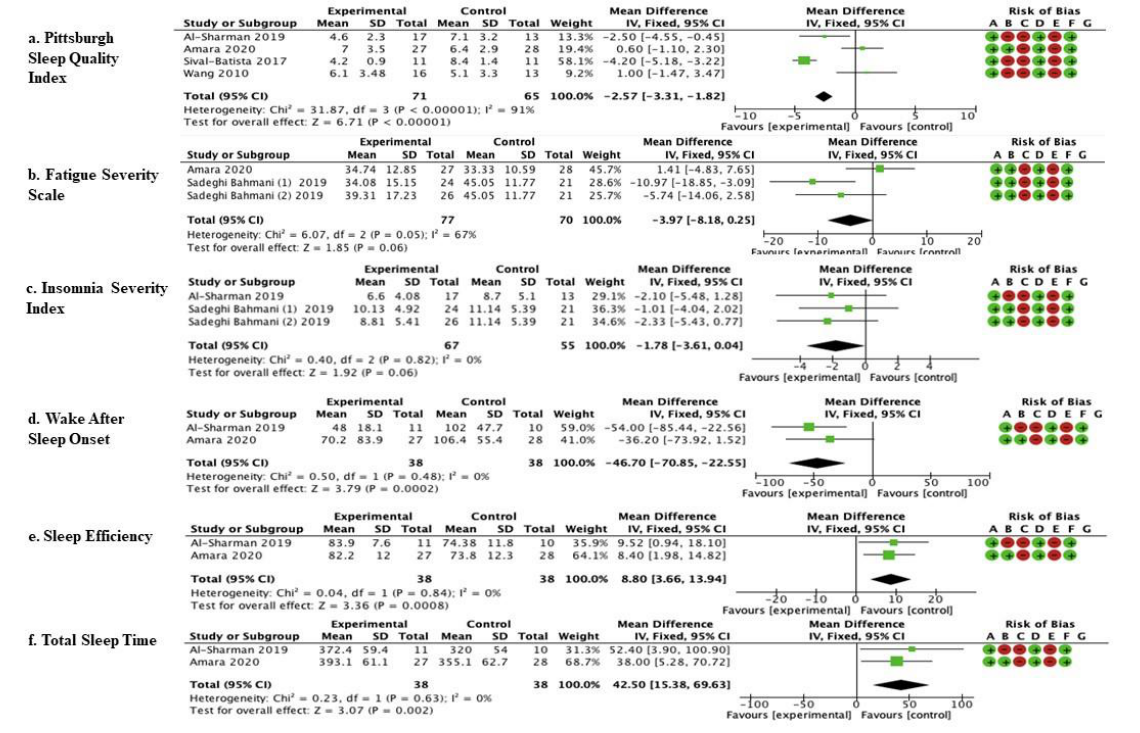
Figure 3. Comparison of physical therapy vs. comparison therapy assessed with clinical scales. low risk of bias, high risk of bias, and unclear risk.